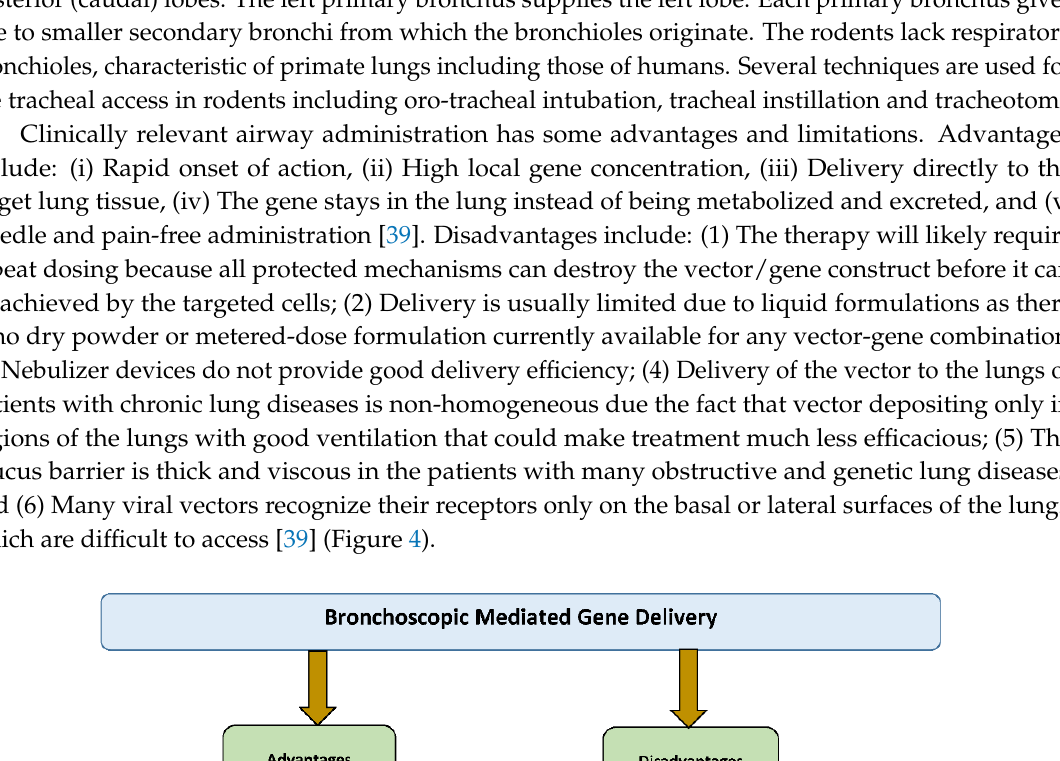
Figure 3. Devices for gene transfer in the respiratory system.